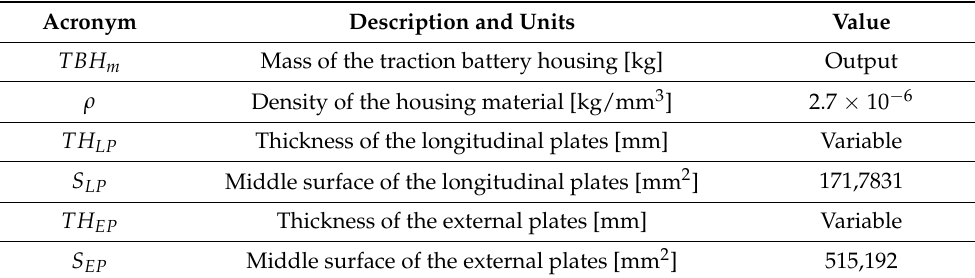
Table 3. Description of the acronyms for the approximation of the traction battery housing mass.